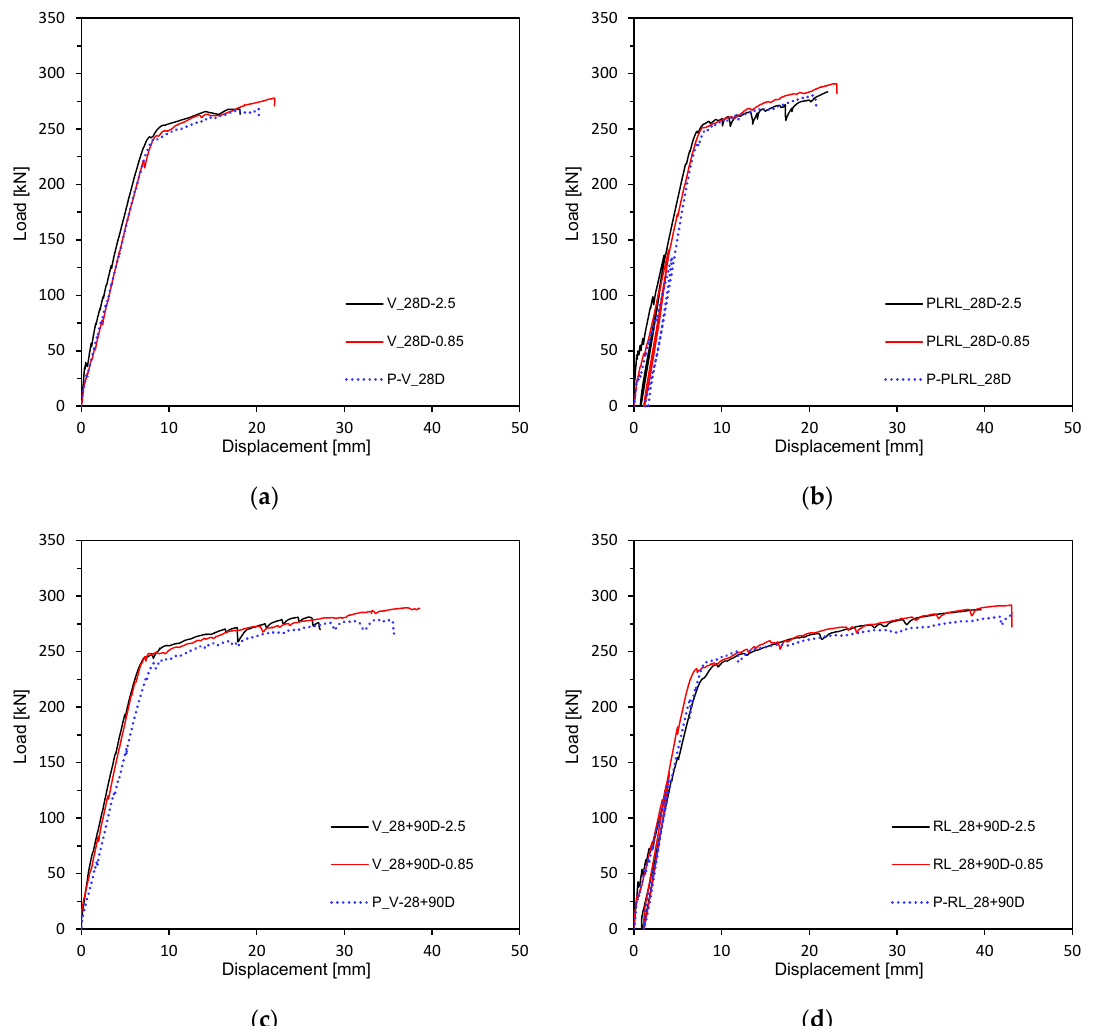
Figure 10. Load-deflection measurement by loading conditions: ( a ) V_28D series; ( b ) PLRL_28D series; ( c ) RL_28D series; ( d ) RL_28 + 90D series.